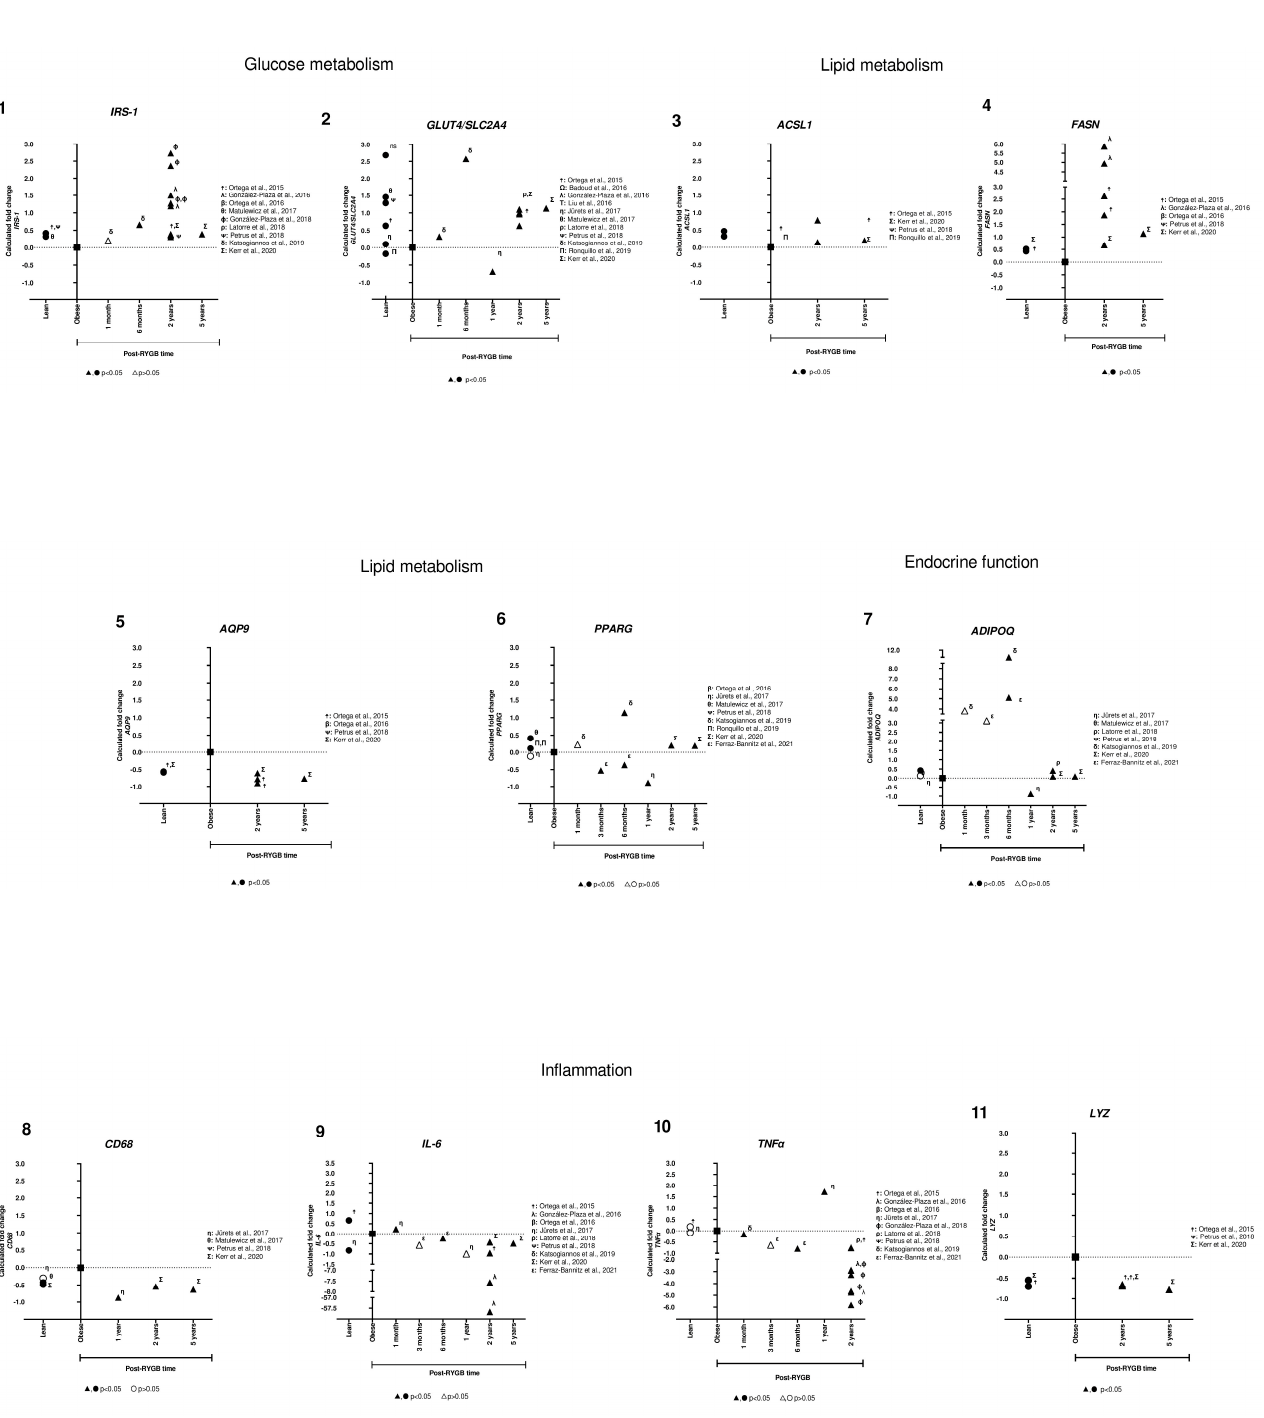
Figure 3. Subcutaneous adipose tissue candidate gene expression among lean, obese, and post‑ RYGB (different timepoints). Comparison of expression levels of each gene among different studies, identified by the Calculated fold change was significant ( p -value < 0.05, ▲ , ● ) or not ( p -value > 0.05, △ , ○ ) . ( α : [38]; ☨ : [47]; Ω : [51]; λ : [41]; Τ : [44]; γ : [40]; η : [46]; θ : [49]; ϕ : [42]; ρ : [43]; ᴪ : [48]; δ : [34]; Π : [50]; Σ : [32]; ε : [31]).